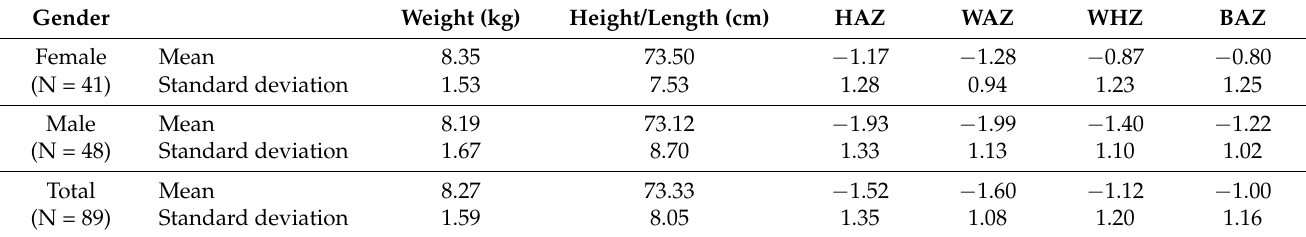
Table 4. Anthropometric values for the studied children distributed by